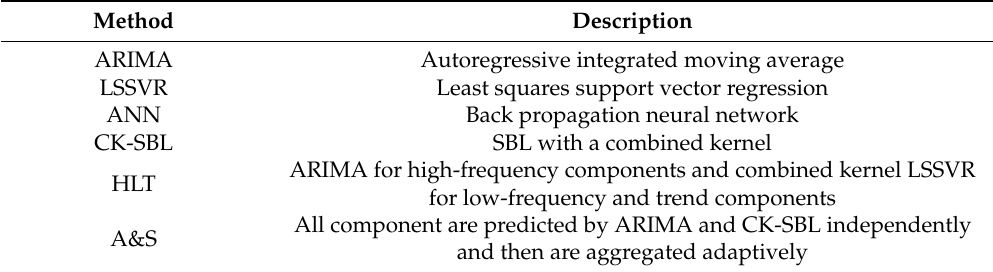
Table 2. Descriptions of all the prediction methods in the